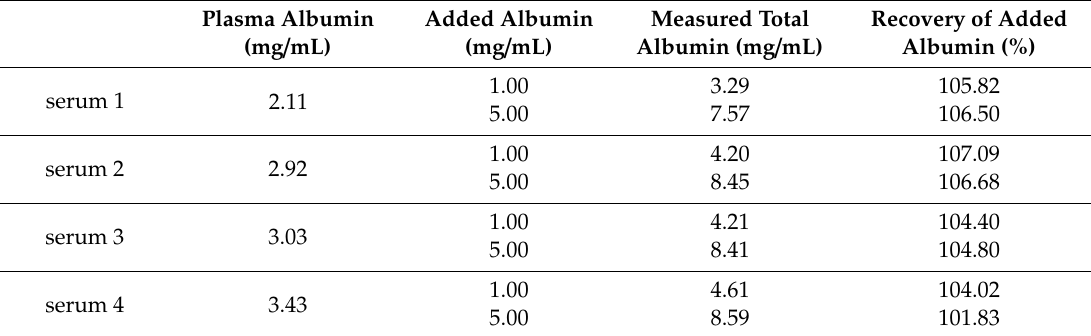
Table 1. Recovery of HSA in supplemented serum analysis.